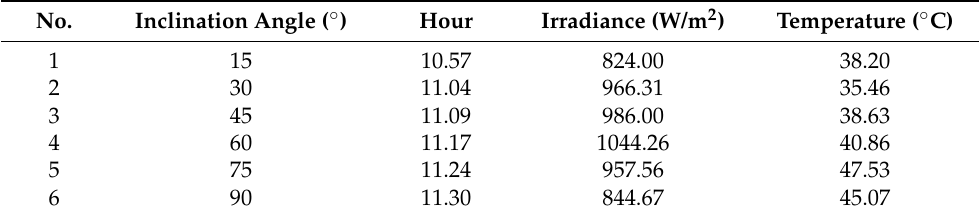
Table 3. The measurement conditions for a grassy